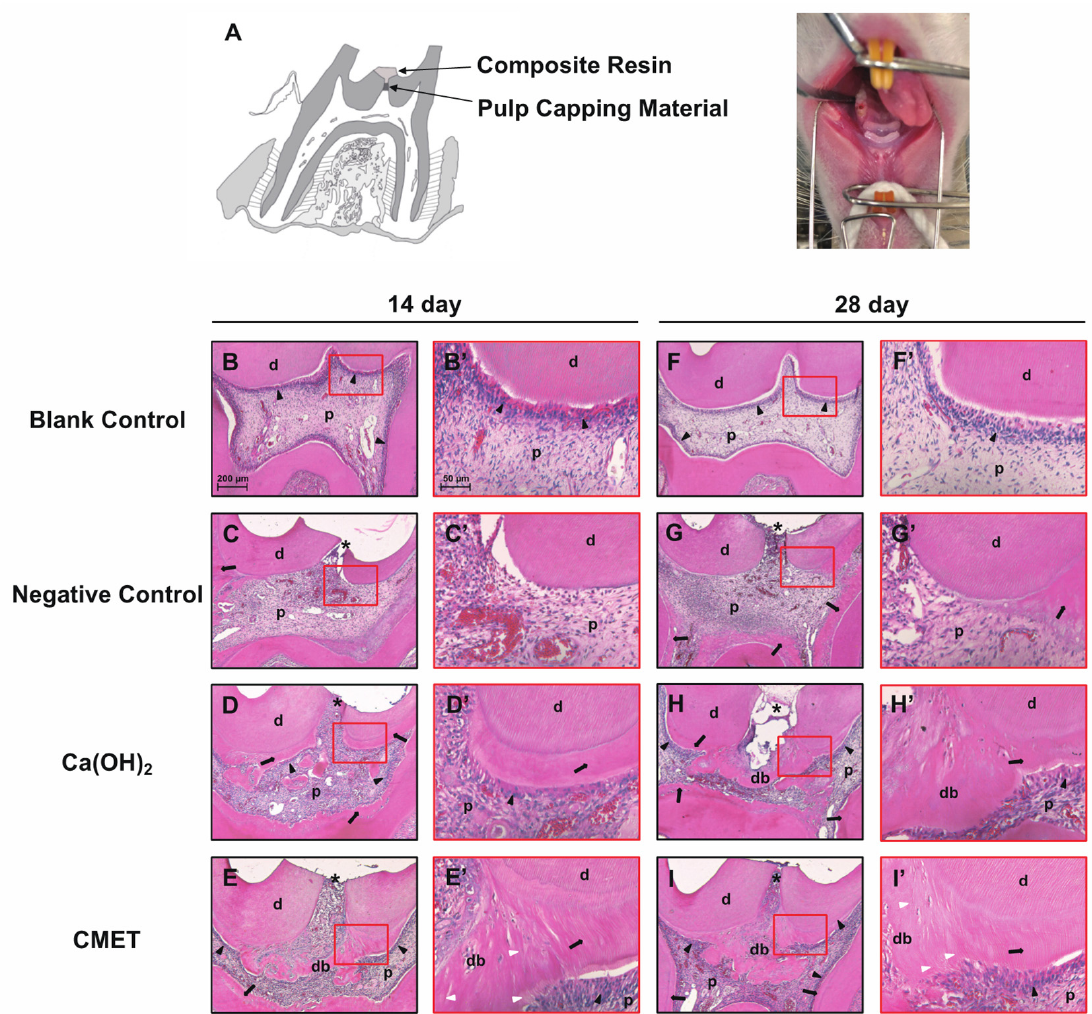
Figure 4. CMET treatment may promote tertiary dentin formation in vivo. ( A ) Schematic of the direct pulp-capping model. Histologic analysis of exposure sites was performed by hematoxylin-eosin staining. The scale bar in the 14-day blank control group image applies to all panels (200 μ m and 50 μ m in the lower and higher magnification images, respectively). On day 14, severe inflammation and the disappearance of odontoblasts polarization were observed in the negative control group ( C ). Tertiary dentin (arrow) formation and local inflammation near the exposure site were observed in the Ca(OH) 2 group ( D ). A thin complete hard tissue bridge formed in the CMET group ( E ). Odontoblasts (black arrowhead) remained polarized in the Ca(OH) 2 and CMET groups. On day 28, heterogeneous reparative dentin was observed in the negative control group, but excluding the exposure site, the pulp tissue remained inflamed ( G ). Continuous hard tissue bridges were found in both the Ca(OH) 2 and CMET groups ( H , I ), but those in the CMET group were homogenous and presented a tubular structure (white arrowhead). ( B’ – I’ ) Higher magnification view of the area demarcated by the open red rectangle in ( B – I ). d, dentin; p, dental pulp; db, dentin bridges; * exposure site.